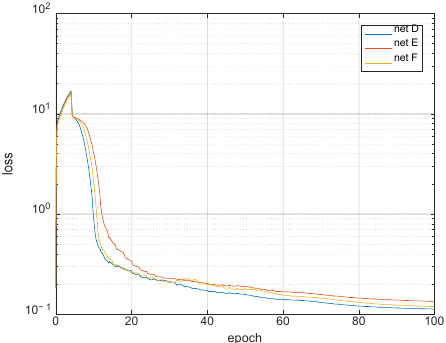
Figure 10. Training loss of correlation distance extraction.